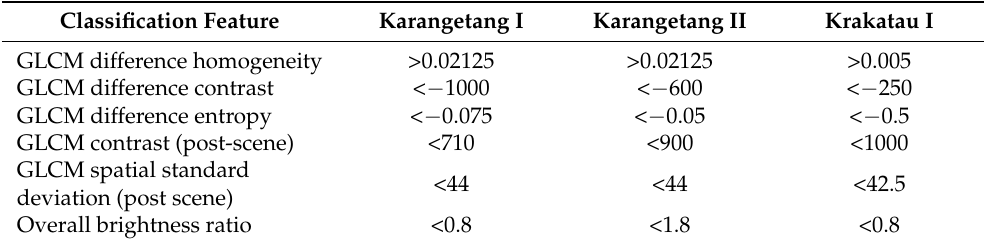
Table 2. Optimal threshold values of GLCM statistics and overall brightness ratio for the classification of lava flows of the events Karangetang I and II and Krakatau I. If a segment meets one of the defined thresholds, it is assigned to the class “potential lava flow area with changes” (see Figure